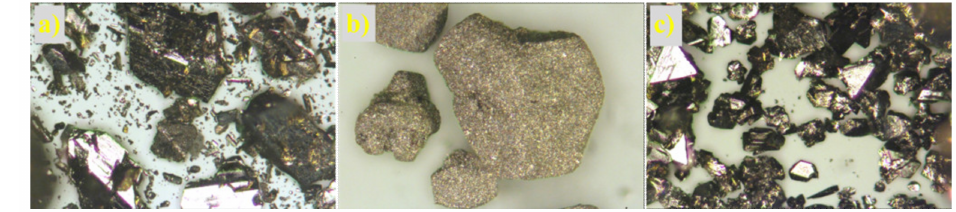
Figure 8. Microscope images of molybdenum carbides at 25 × magnification obtained from